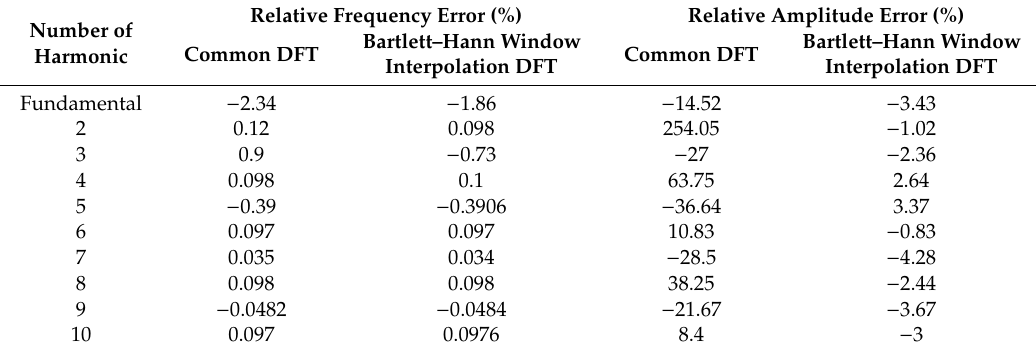
Table 2. Comparison of ordinary DFT algorithm and Bartlett–Hann window